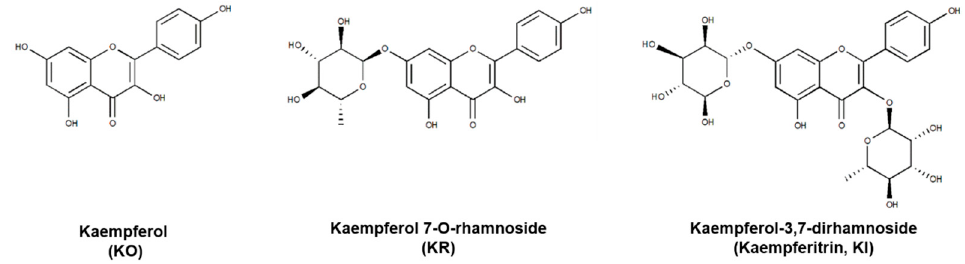
Figure 1. The chemical structures of kaempferol (KO), kaempferol 7-O-rhamnoside (KR), and kaempferol-3,7-dirhamnoside (kaempferitrin, KI). Chemical structures were generated using ChemDraw Professional 8.0.